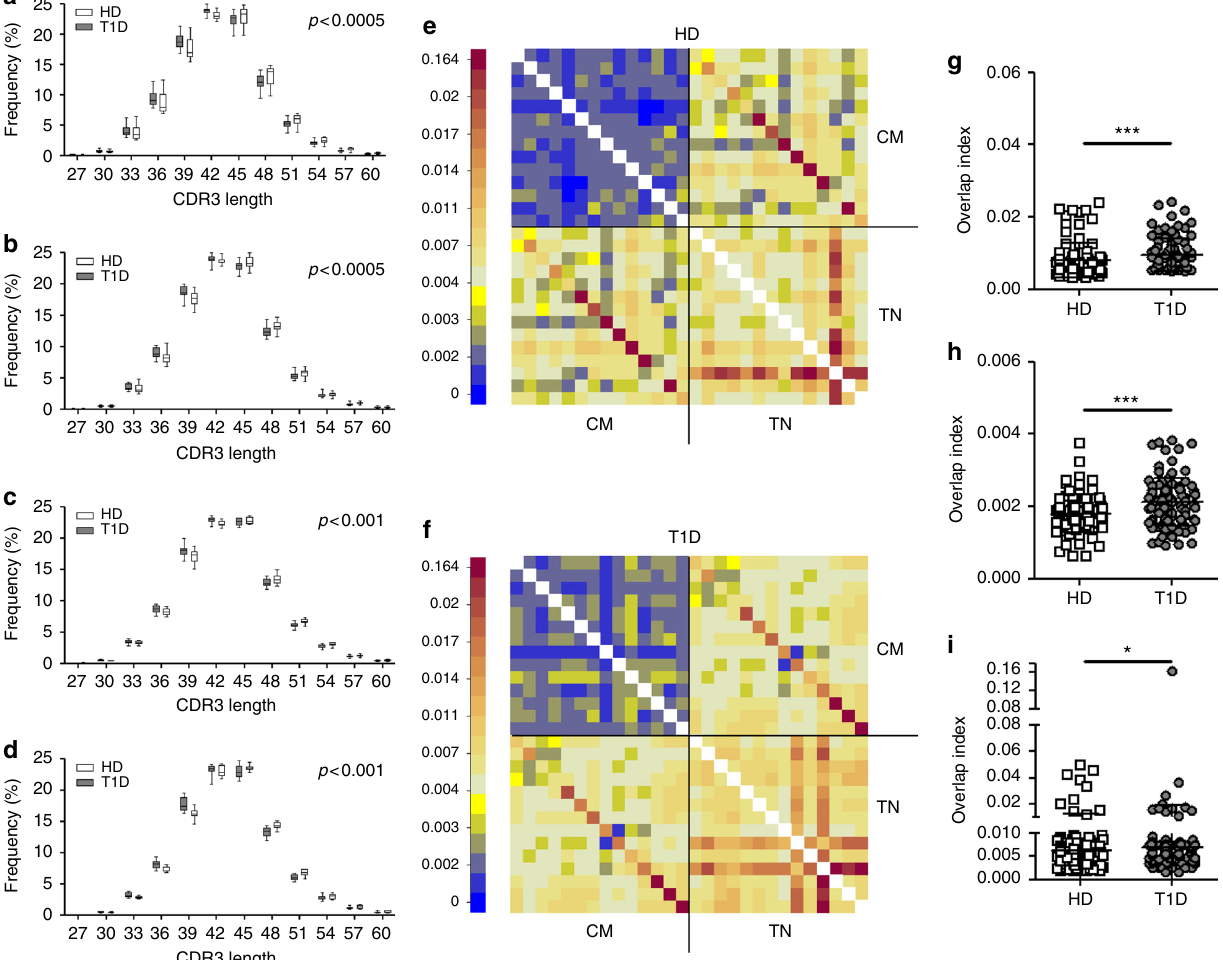
Fig. 2 TCRB CDR3s are shorter and show greater similarity among T1D patients. a – d TCRB CDR3 nucleotide length of productive unique sequences from true naive (TN) a , central memory (CM) b , regulatory (Treg) c and stem cell-like memory (Tscm) d T cells present biased length distribution in patients, represented by higher frequencies of short TCRB CDR3s (and lower frequencies of long ones) (one-sided bootstrap univariate Kolmogorov – Smirnov test). e , f Overlap indices were calculated for TN and CM TCRB nucleotide repertoires from 14 healthy donors e and 14 T1D patients f as described in the Methods section, showing higher values among patients. g – i Overlap indices for TN/TN g , CM/CM h and TN/CM i cell subtypes (Mann – Whitney U-test). * p < 0.05; *** p < 0.001. Lines represent the mean ±